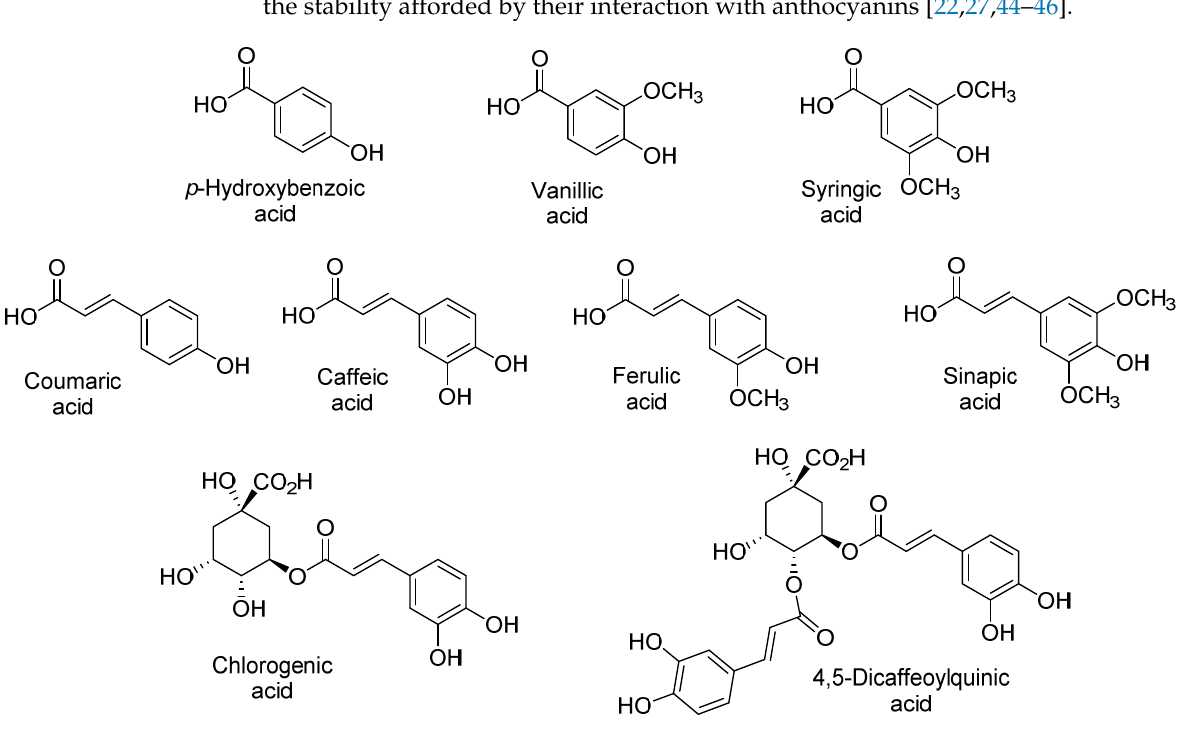
Figure 3. Main phenolic acids identified in sweet potato.